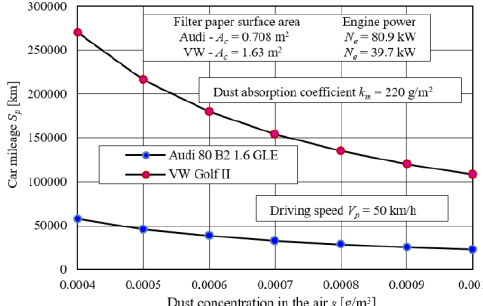
Fig. 14. Vehicle mileage until the filter reaches the permissible resistance depending on dust concentration in the air and different filter paper surfac- es from two different filters